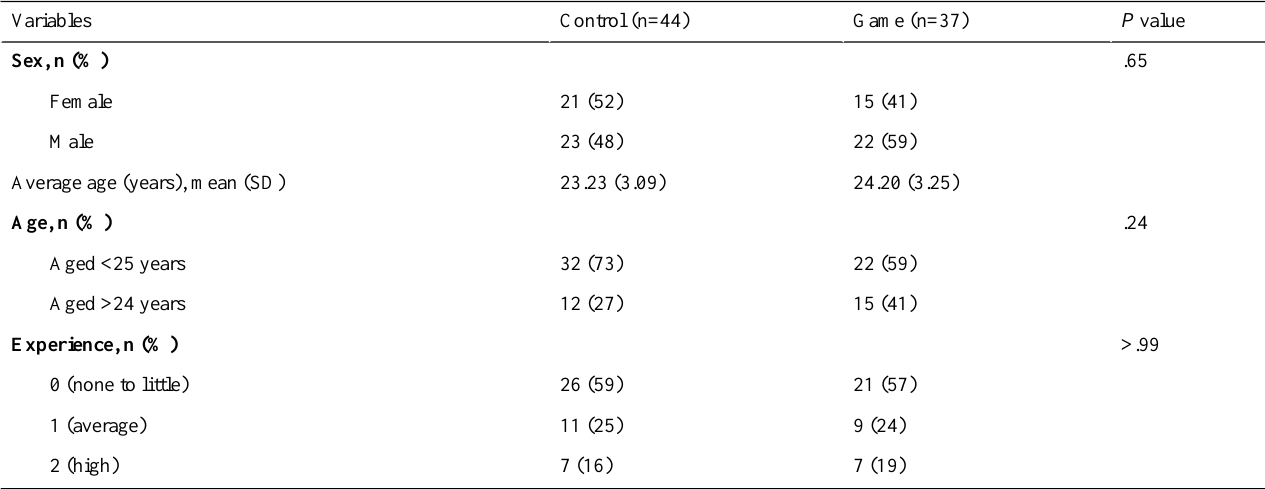
Table 1. Sample description and comparison of study 1 in baseline